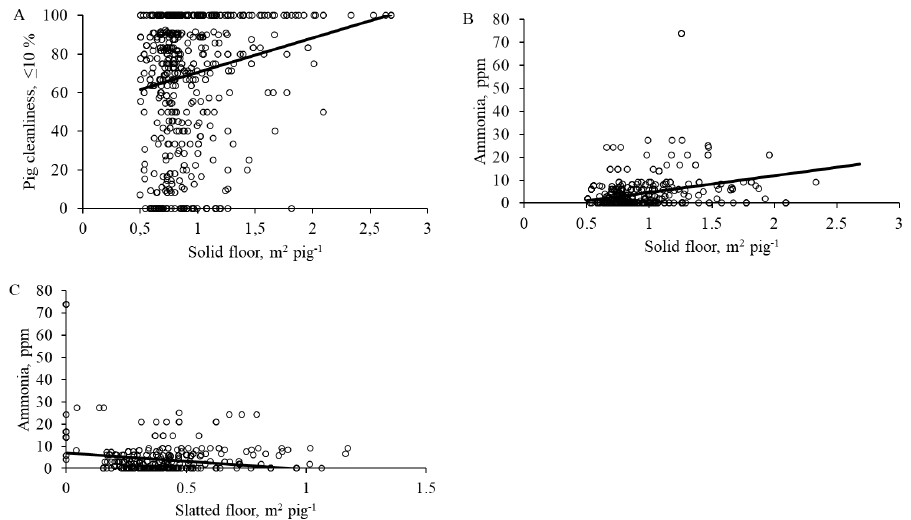
Figure 3. Effect of pen size on pig cleanliness and ammonia concentration. ( A ) Pig cleanliness and solid floor area per pig (F 1472 = 19.7; p < 0.001). ( B ) Ammonia concentration and solid floor area (F 1472 = 69.3; p < 0.001). ( C ) Ammonia concentration and slatted floor area (F 1472 = 100.3; p <